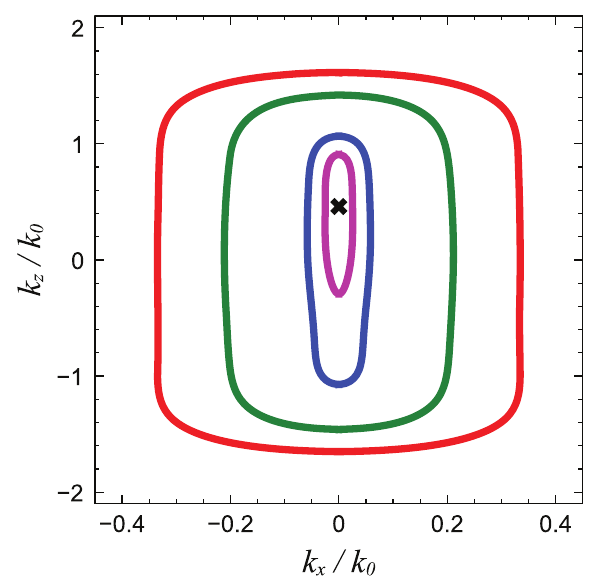
Figure 4. Numerically-computed equi-frequency contours for the synthesized multilayered metamaterial (with parameters as in Figure 2 caption), at angular frequencies x = 0.9 x 0 , x = 0.99 x 0 , x = 0.995 x 0 , x = 0.999 x 0 (red, green, blue, magenta curves, respectively). At x = x 0 , the equi-frequency contour degenerates to the DBE stationary point (indicated with a black-cross